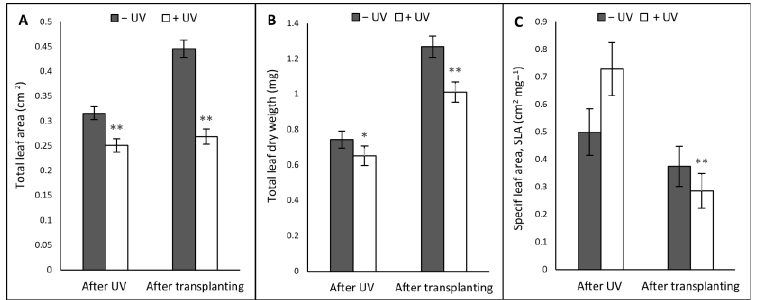
Figure 5. Parameters measured were leaf area (cm 2 ) ( A ), leaf dry weight (LDW, mg) ( B ) and specific leaf area (SLA, cm 2 mg − 1 ) ( C ). Before the UV exposure stage, the mean of the total leaf area was 0.216 cm 2 , the LDW was 0.638 mg, and the SLA was 0.451 cm 2 mg − 1 . Asterisks indicate a significant difference between the UV treatments with p < 0.05 (*) or p ≤ 0.001 (**).